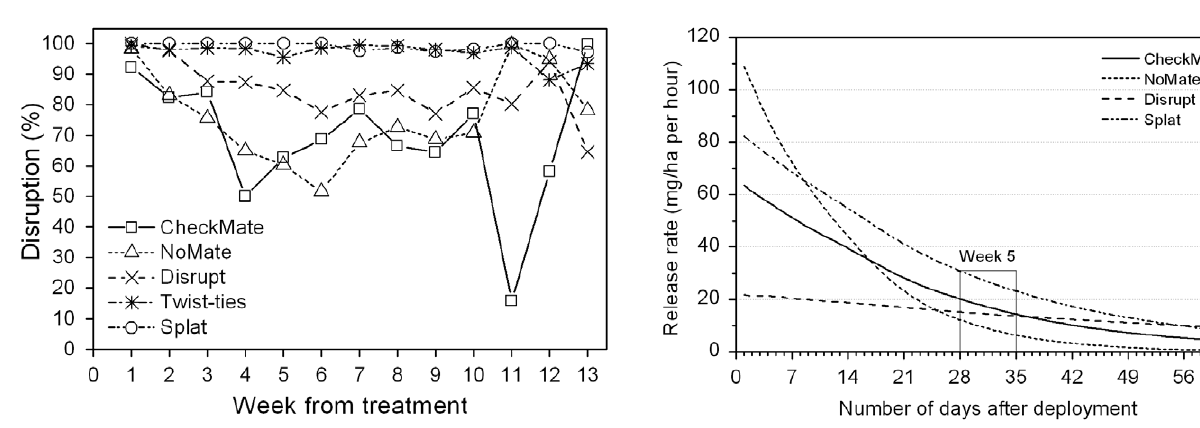
Figure 2. Pheromone release rates (mg ha 2 1 hr 2 1 ) of the main component (E-11-tetradecen-1-yl acetate) of four formulations applied for mating disruption. Release rates were calculated using actual application rates (mass/area) and the change in mass over time from decay rate curves (Fig. S4). ‘Week 5 9 is highlighted as this is mentioned specifically in the results section. Values for Disrupt and CheckMate are based on the deployment target of 40 g pheromone ha 2 1 . Slight under-application of NoMate and over-application of Splat, by 50%, were taken into consideration. See methods for details.